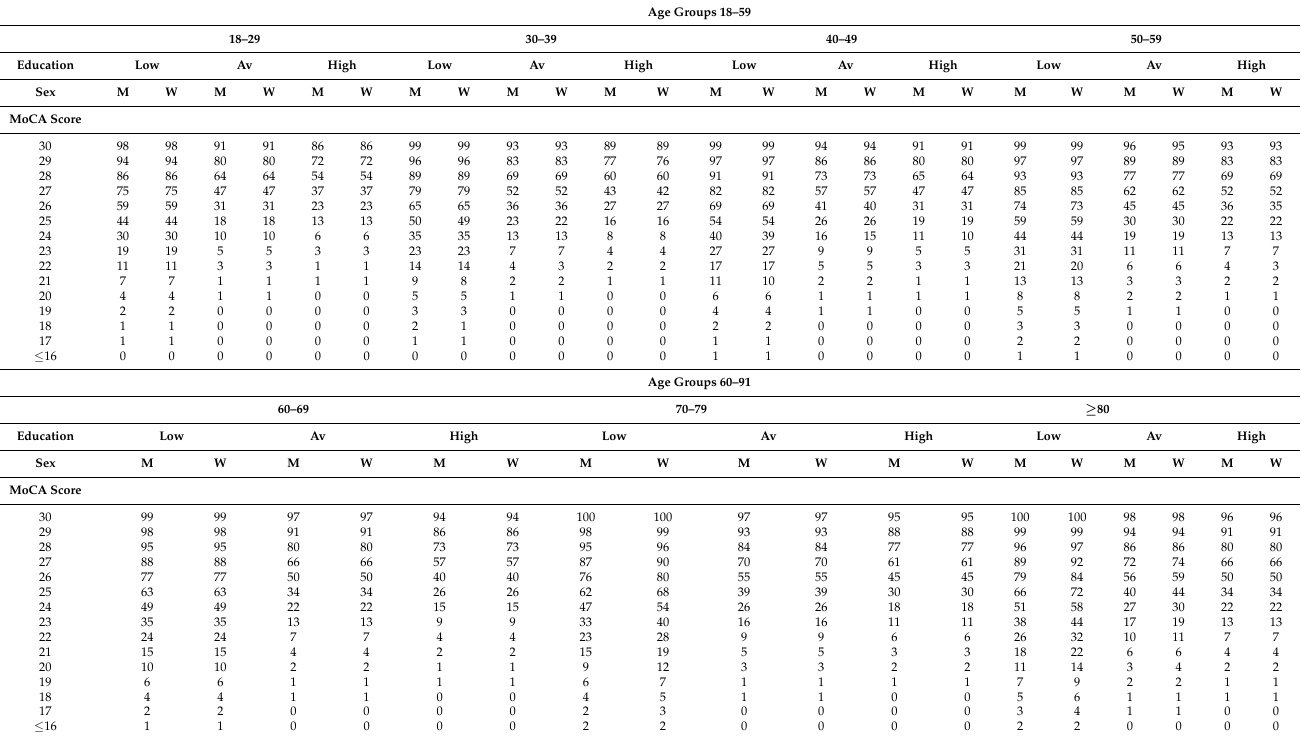
Table A1. Percentile scores for the MoCA total score stratified per age group, education level, and